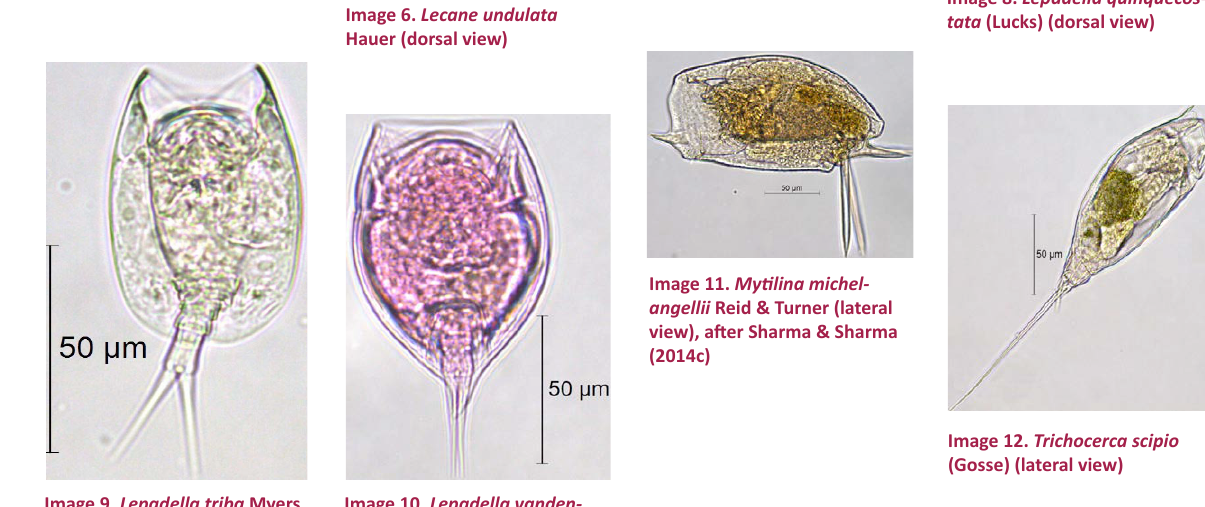
Image 10. Lepadella vanden- brandei Gillard (ventral view)